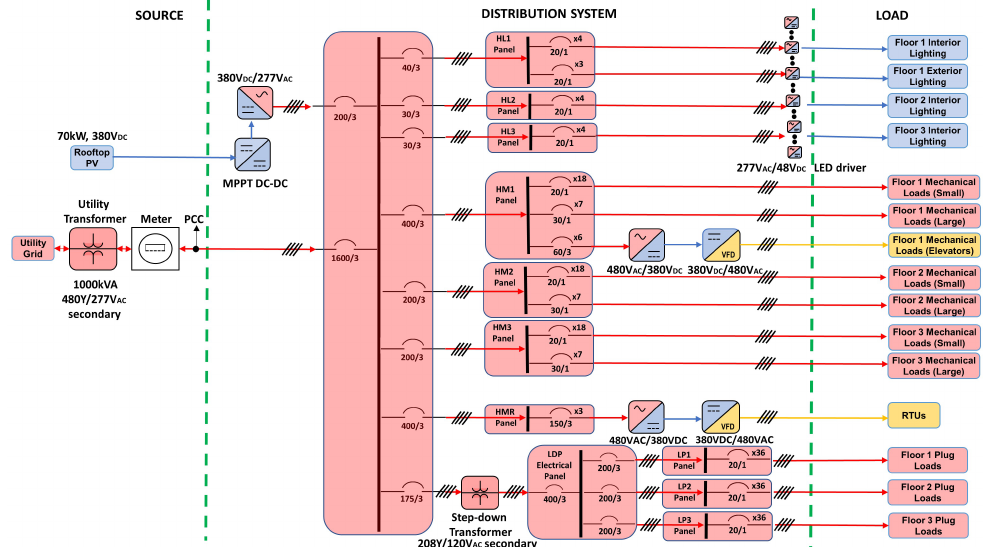
Figure 4. Modified AC electrical distribution system CRBM with rooftop